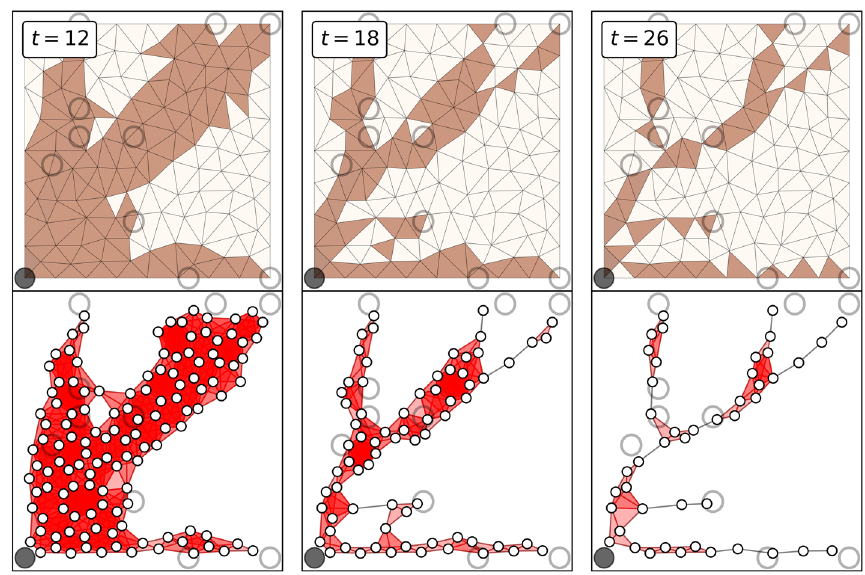
Fig. 2 Temporal hypergraphs. Top row: different timestamps of the sequence { µ t } ; triangles are a discretization of [ 0,1 ] 2 . Bottom row: hypergraphs extracted for µ t at the time steps displayed on the top row; triangles are highlighted in red. In both rows, filled and empty circles correspond to the support of f + and f − , i.e. sources and sinks, respectively. This sequence is obtained for β =